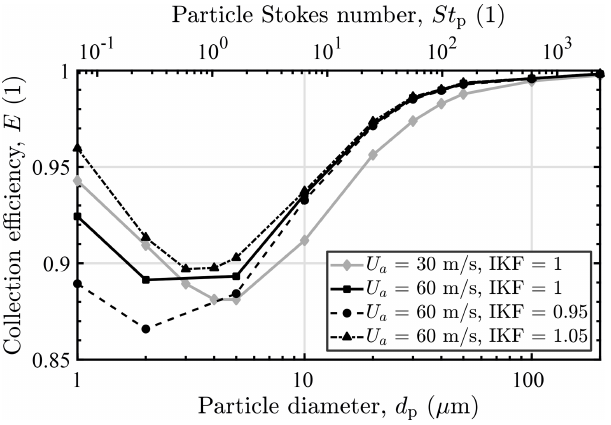
Figure 3. Isoaxial TW inlet collection efficiency as a function of particle diameter determined from combined CFD and Lagrangian particle tracking simulations at different freestream airspeeds U a and isokinetic factors (IKFs), assuming an ambient air tempera- ture and pressure of − 5 ◦ C and 1013 . 25hPa, respectively. Particle Stokes numbers given in the upper x axis are only valid for 60ms − 1 data. The lines between the evaluation points are used to guide the eye.